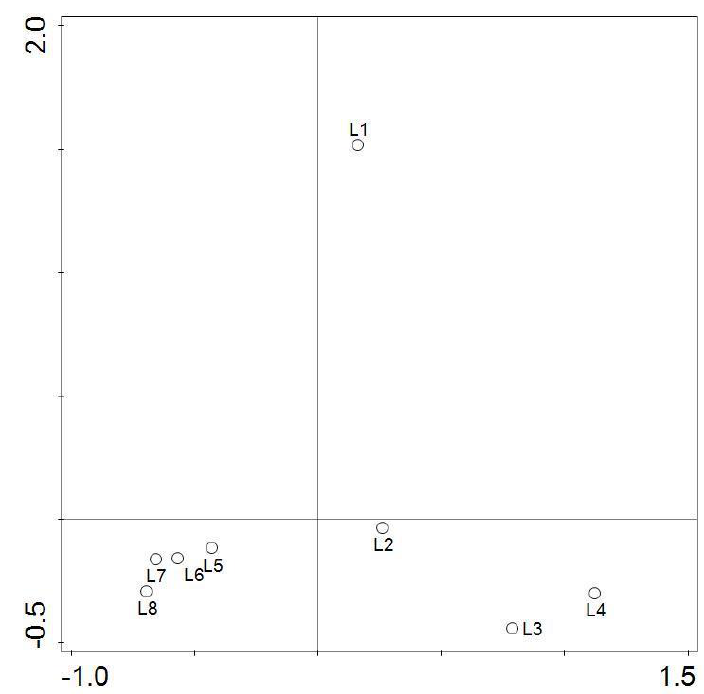
Figure 5. PCA biplot of sample scores of water and surface sediment chemistry parameters in the mangrove forest of Khor al Beida.